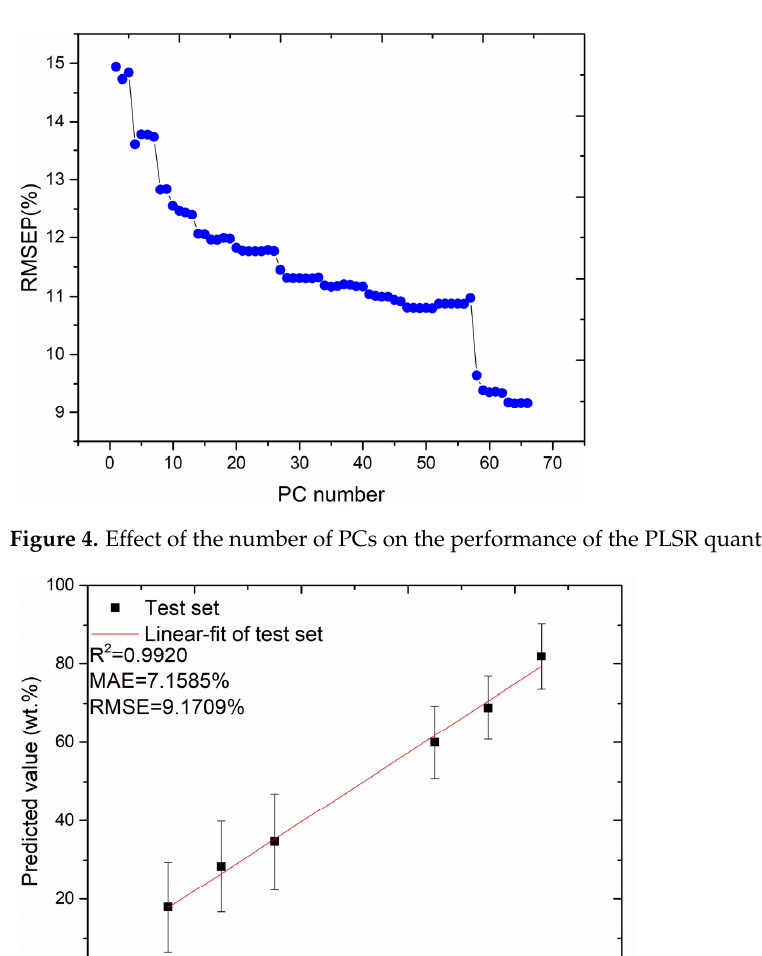
Figure 5. Plot of the relationship between the predicted and standard values of the test set obtained for the first 64 PCs as inputs to the PLSR model.